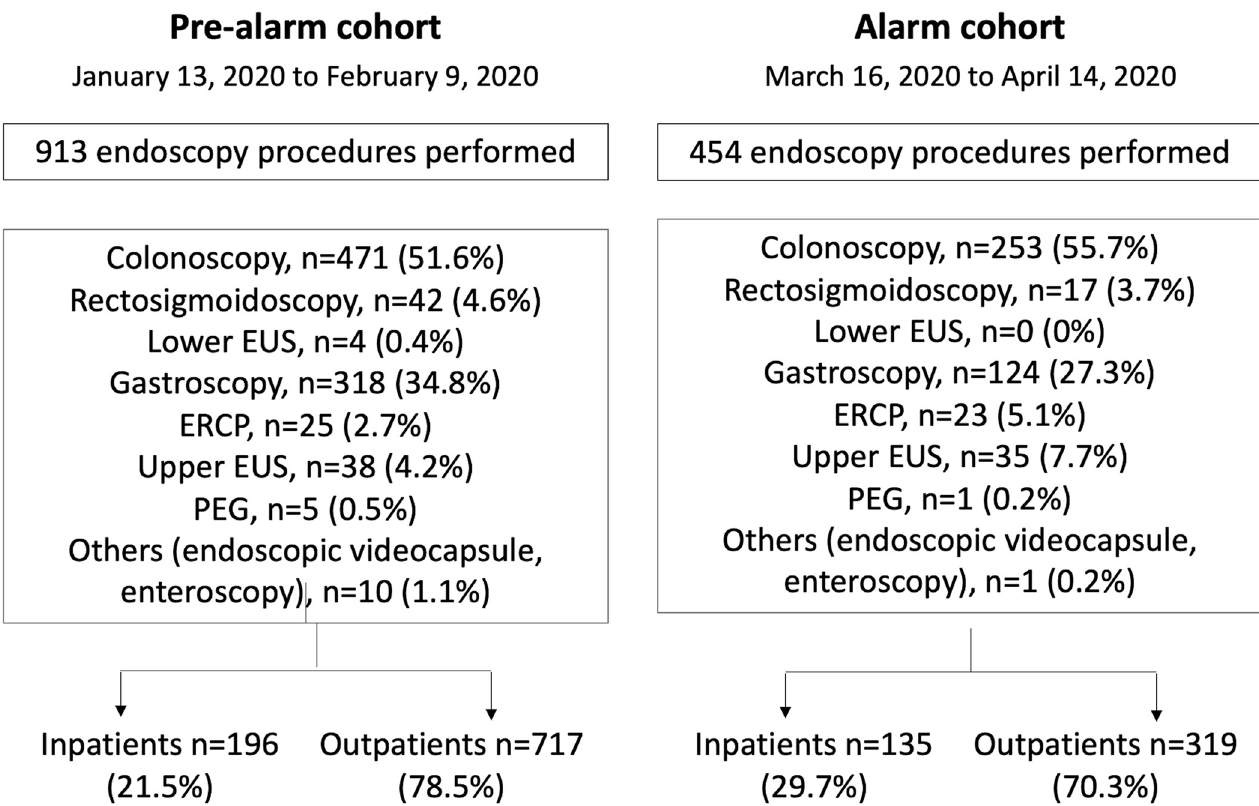
Fig 2. Flow-chart with detailed type of endoscopy procedures performed in the pre-lockdown and lockdown cohorts. ERCP: Endoscopic retrograde cholangiopancreatography, EUS: Endoscopic ultrasound, PEG: Percutaneous endoscopic gastrostomy.